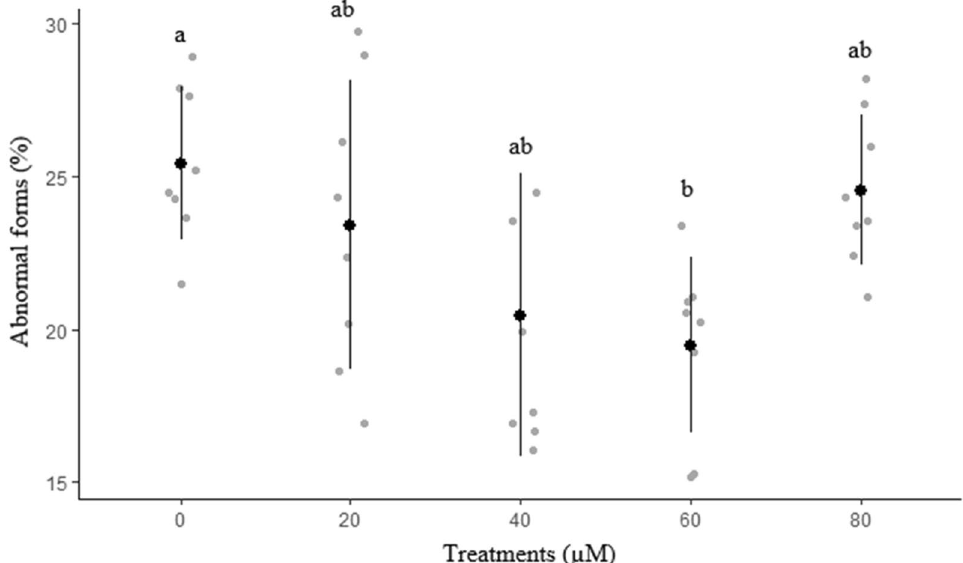
Figure 3. Effect of different levels of rosiglitazone on morphology status of ram